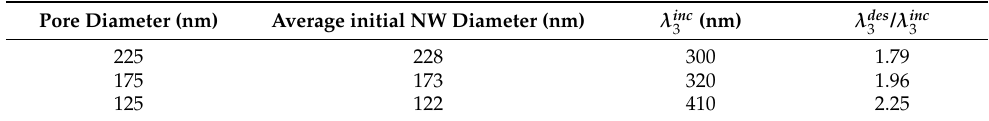
Table 4. Parameters of radius-dependent growth kinetics of SAE GaAs